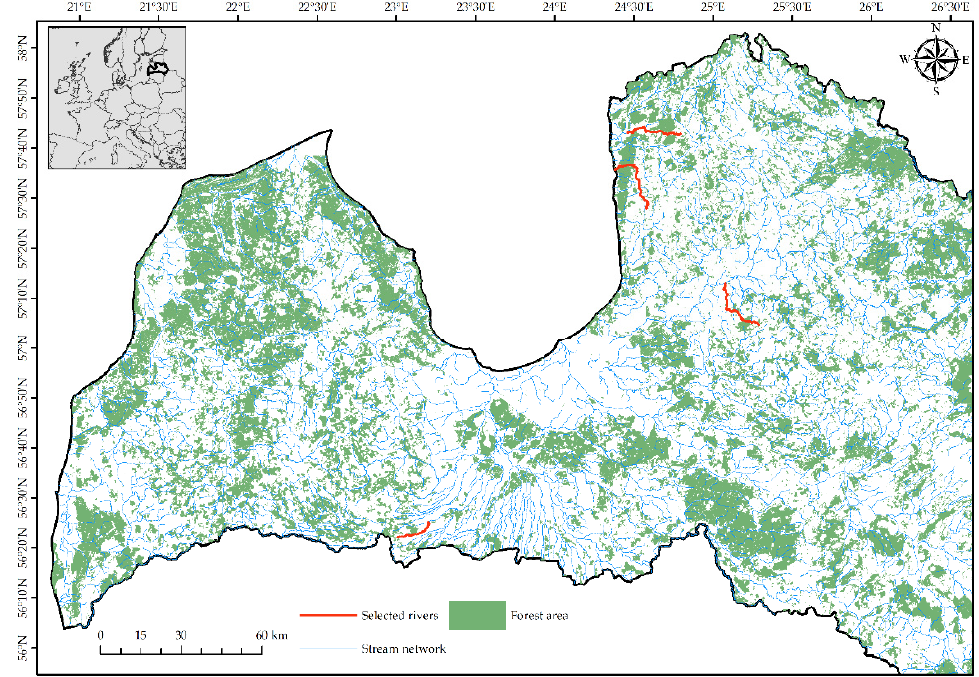
Figure 1. Location of the selected four small-to-medium-sized rivers in Latvia. The blue color shows all stream networks, the green color all forested areas.